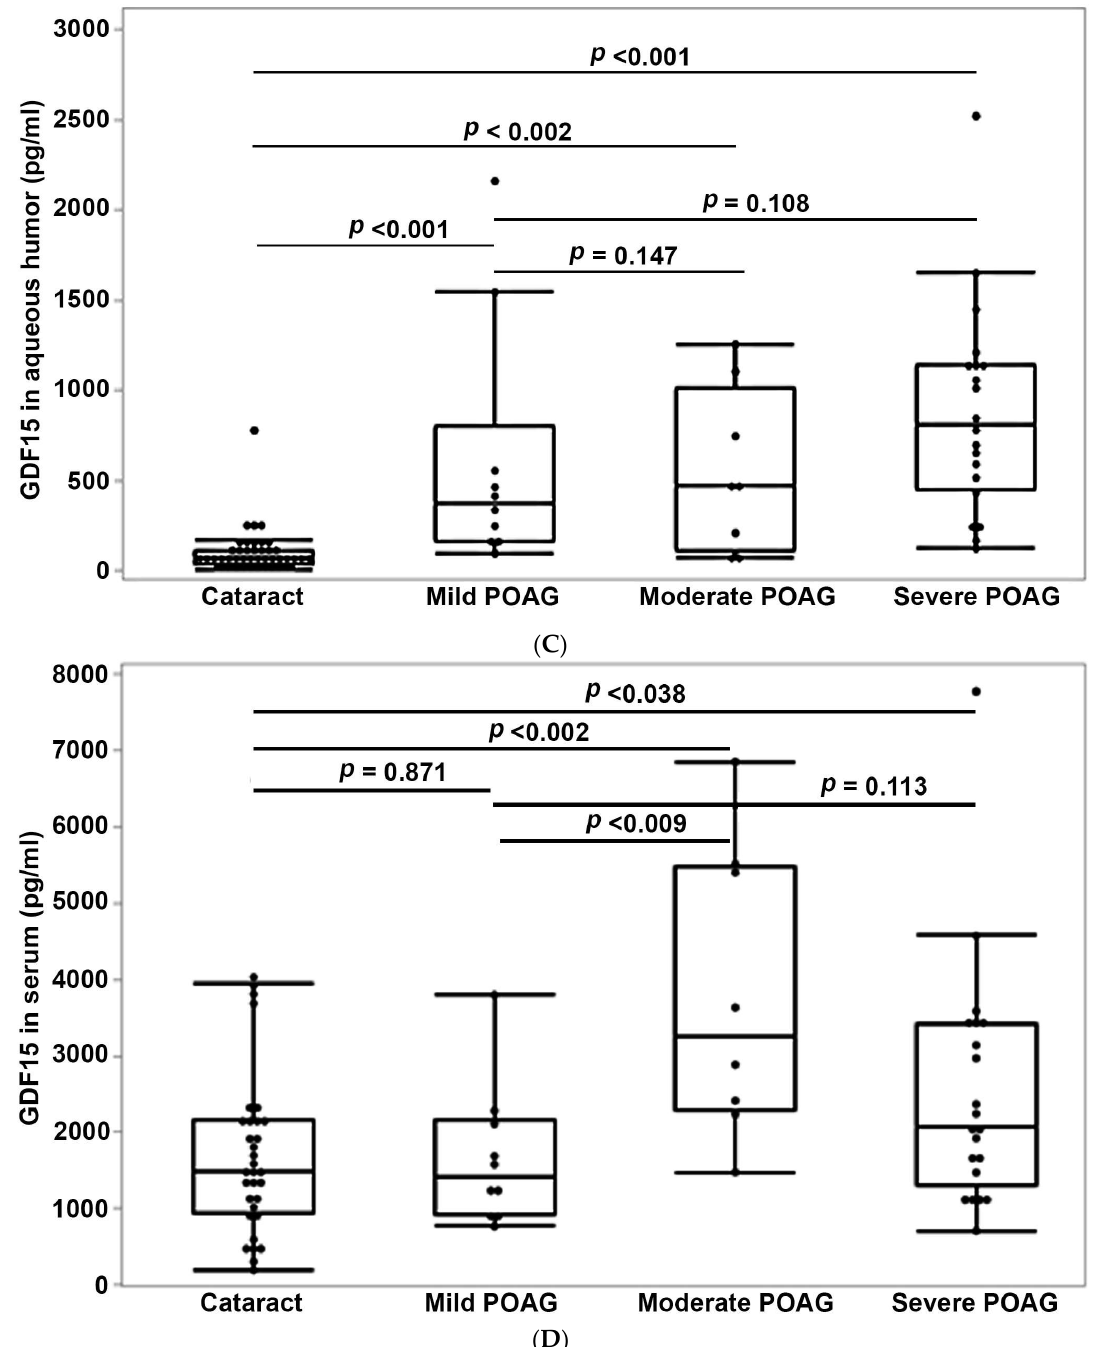
Figure 3. Relationship between aqueous humor and serum GDF15 levels and disease severity of POAG. To determine whether elevated levels of GDF15 either in the AH or serum reveal a positive association with disease severity of glaucoma, POAG patients from a small cohort study were divided into mild, moderate, and severe glaucoma based on median deviation of visual field loss and GDF15 levels from the categories analyzed. ( A ) Overall, there was a significant difference in median deviation of visual field loss among the three groups, based on the Kruskal–Wallis test ( p < 0.001). Though the median deviation was not found to be significant between mild and moderate POAG, it was significant between mild to severe, and moderate to severe POAG based on the Wilcoxon rank sum test. ( B ) Cup-to-disk ratio showed a significant difference between cataract patients versus mild, moderate, and severe POAG, and between mild to moderate, and mild to severe POAG based on the Wilcoxon rank sum test. ( C ) AH GDF15 levels were significantly elevated between cataract and mild, moderate, and severe POAG, but not different between mild and moderate, and mild and